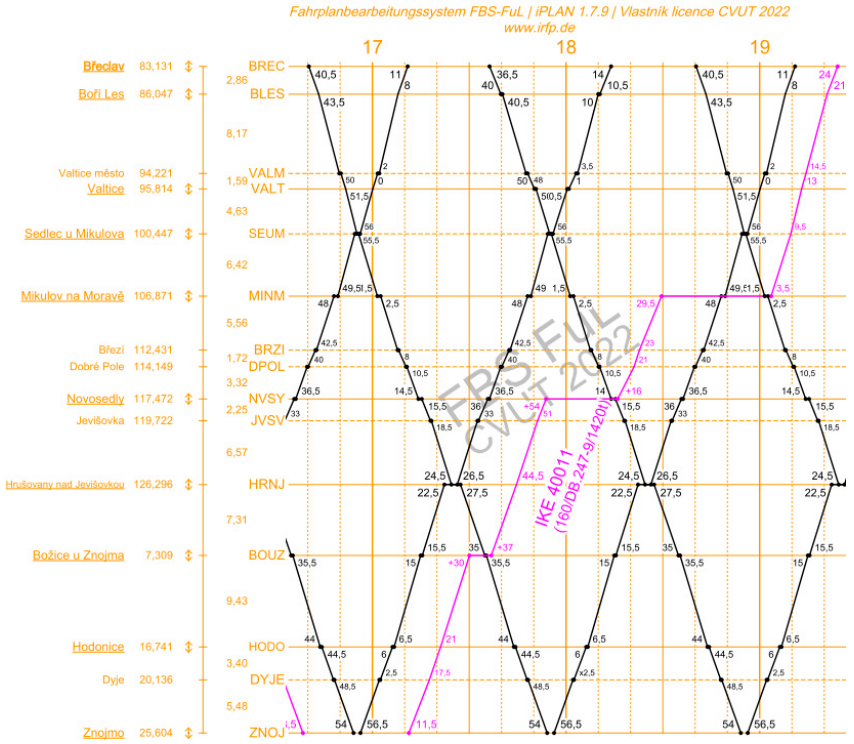
Figure 7. Proposed freight train path on the rail line 246—direction to B ř eclav (data: [1,27]). Source: Authors.